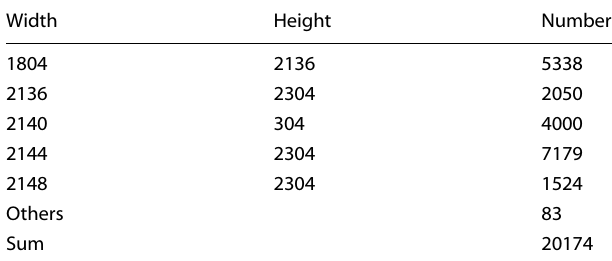
Table 4. The size distribution of LCR